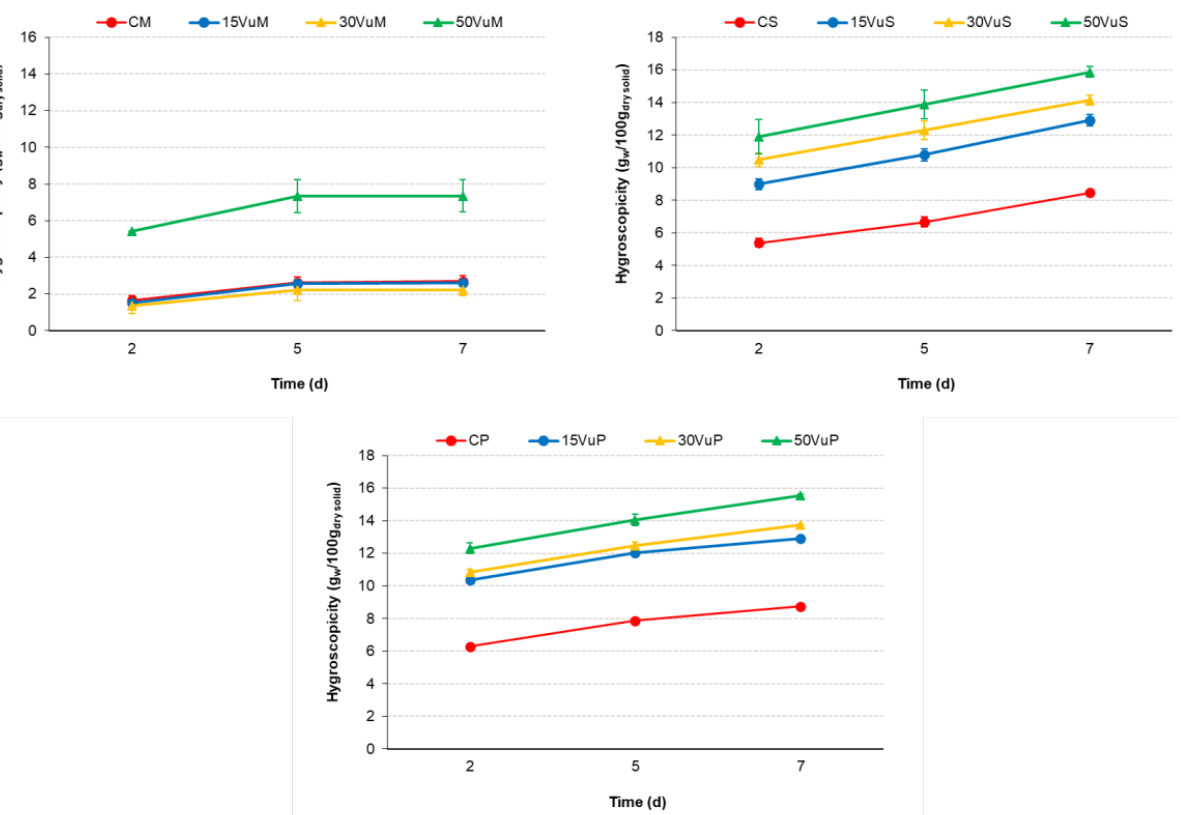
Figure 5. Hygroscopicity of each powder sample along with assay time. Mixtures (M): CM, 15VuM, 30VuM, and 50VuM; Section of pellet (S): CS, 15VuS, 30VuS, and 50VuS; Powder (P): CP, 15VuP, 30VuP, and 50VuP. Table 1. Pearson correlation coefficients among the studied physicochemical parameters of